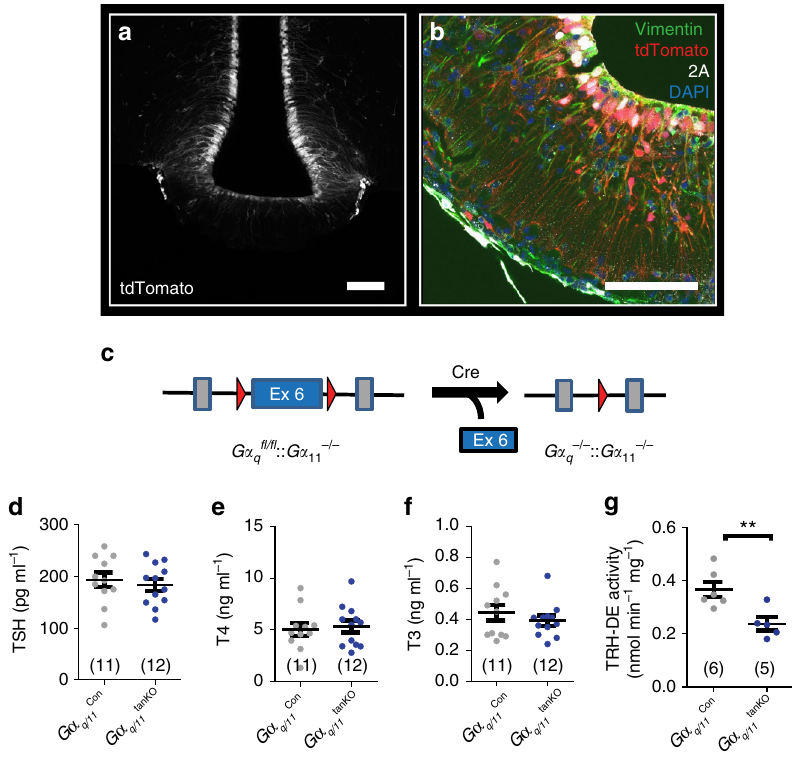
Fig. 4 Basal activity of the HPT axis is not changed in mice with a tanycyte-speci fi c de fi ciency of G α q/11. a tdTomato ( gray ) was expressed in tanycytes 2 weeks after injecting AAV-Dio2-iCre-2A-GFP in Ai14 reporter mice ( scale bar , 100 µ m). b Immuno fl uorescence staining of iCre-2A ( white ; 2A) and vimentin ( green ) showed colocalization in tdTomato-positive tanycytes ( red ; scale bar , 75 µ m). c Knockout strategy to generate G α q/11 tanKO mice. Cre recombinase was transduced by injecting AAV-Dio2-iCre-2A-GFP into the lateral ventricle of G α q fl / fl :: G α 11 − / − mice. AAV-Dio2-GFP injected G α q fl / fl :: G α 11 − /+ into the lateral ventricle were used as control ( G α q/11 Con ) d – f Basal plasma concentrations of TSH ( d ; p = 0.59), T4 ( e ; p = 0.75), and T3 ( f ; p = 0.34) 3 weeks after inducing the knockout by injecting rAAV ( G α q/11 Con , gray ; G α q/11 tanKO , blue ). g TRH-DE activity in G α q/11 Con mice ( gray ) and G α q/11 tanKO ( blue ) 3 weeks after rAAV injection. ** p = 0.0093 (two-tailed Student ’ s t -test); mean ± S.E.M.; n , as